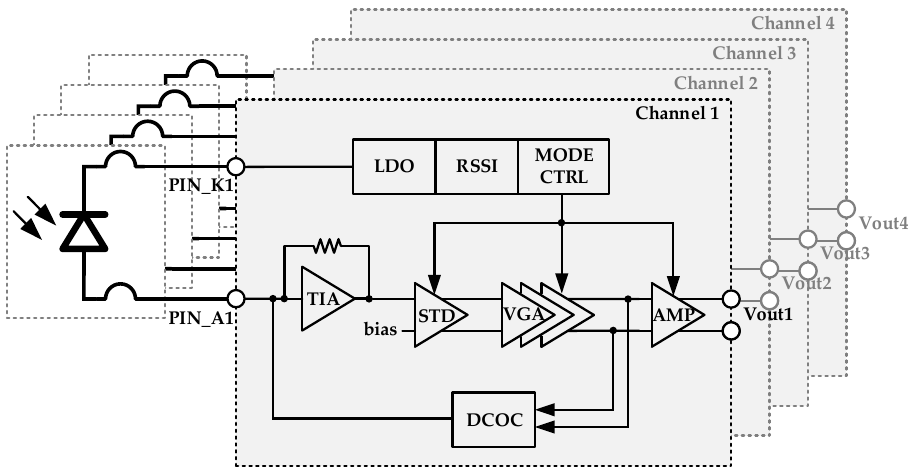
Figure 1. A block diagram of the optical receiver.